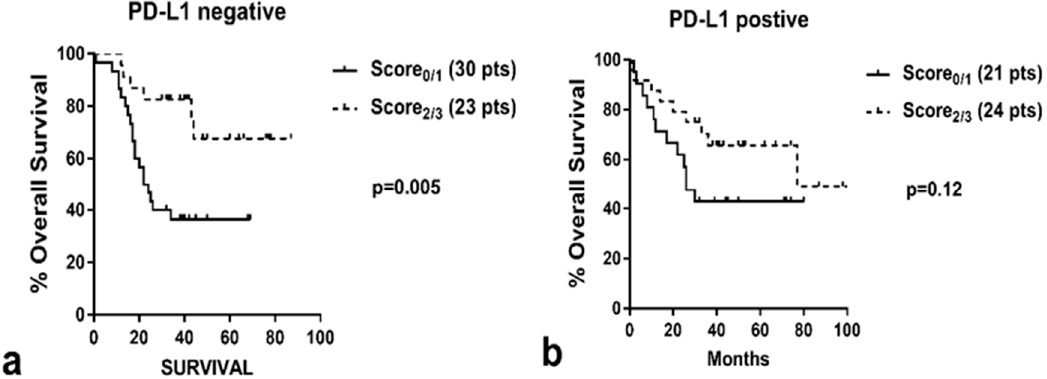
Figure 4. Kaplan–Meier (disease-specific) overall survival curves stratified for iNOS+ TIL score ( a ) in tumors with lack of PD-L1 expression in cancer cells, and ( b ) in tumors positive for PD-L1 expression in cancer cells.